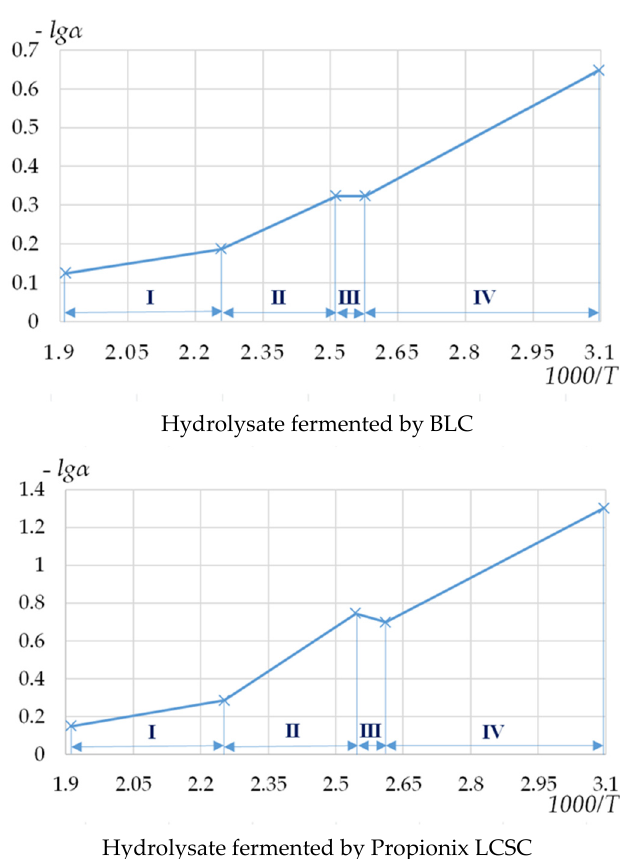
Figure 2. Dependences of sample mass change (TG), mass change rate (DTG), temperature (DSC), and temperature change rate (DDSC) measured by thermal gravimetric and differential-scanning calorimetry analysis.